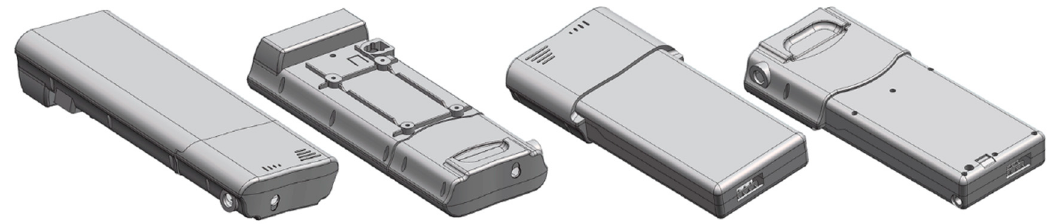
Figure 3. Kalkhoff Groove 28” battery pack model.